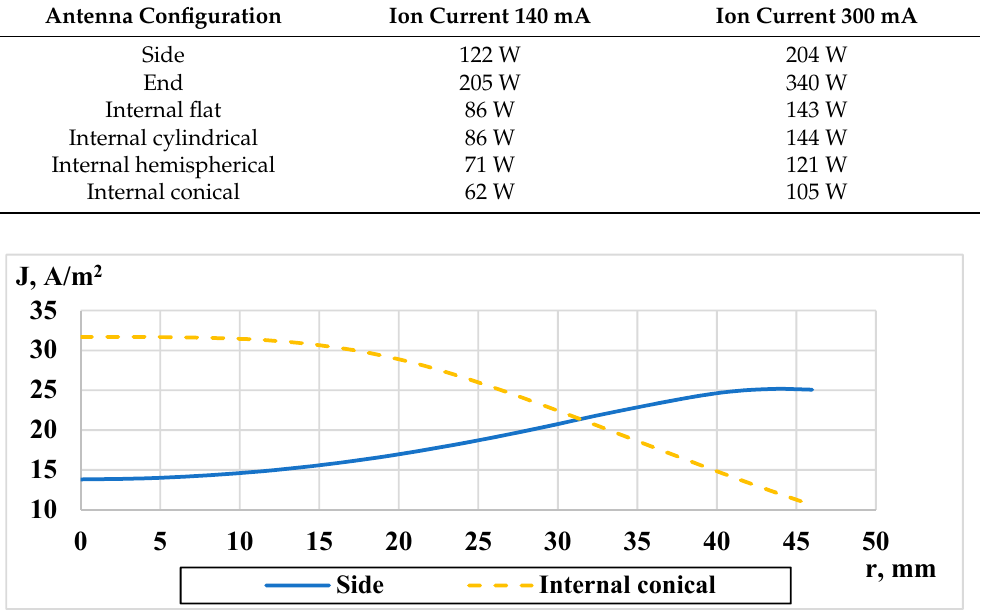
Table 1. RF power required to provide the given extracted ion current at a constant propellant flow